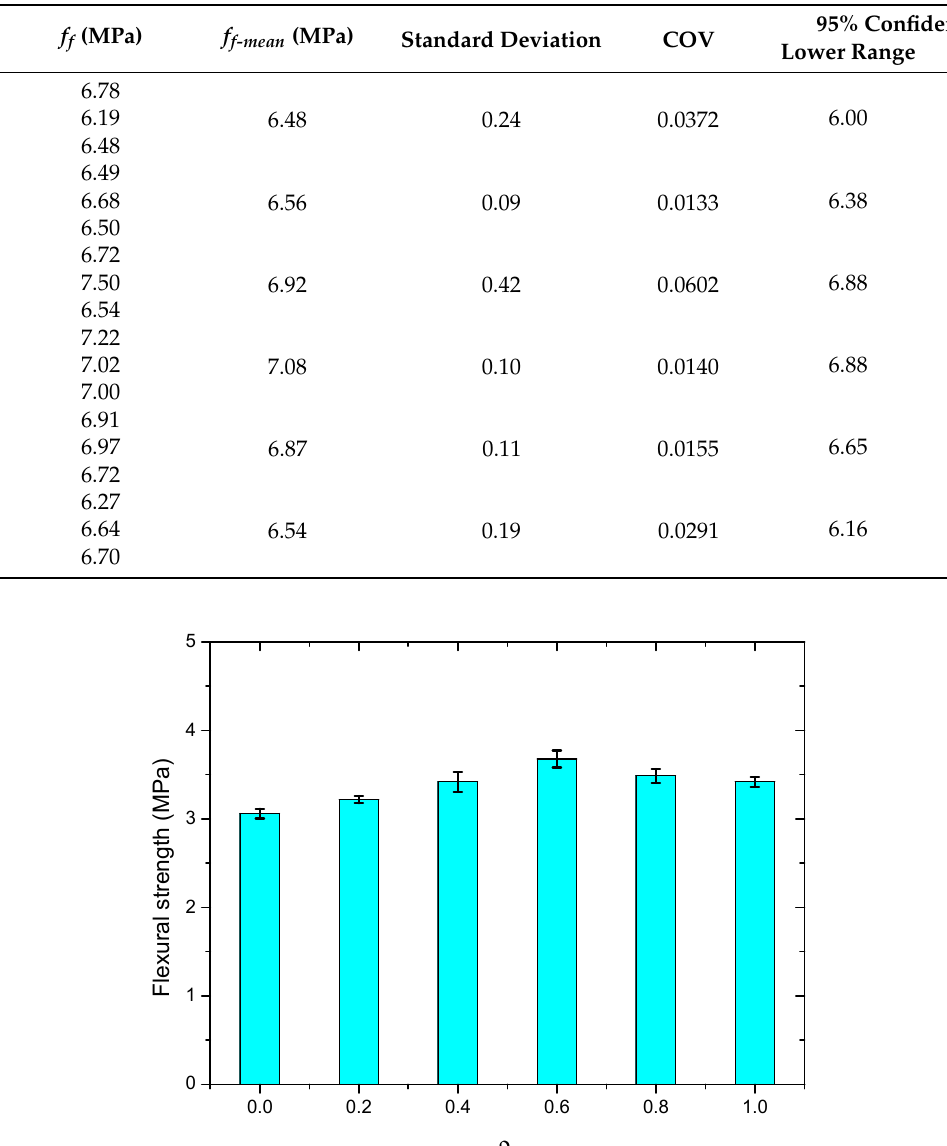
Table 11. Results of flexural tests of SWSSC with different mixes.